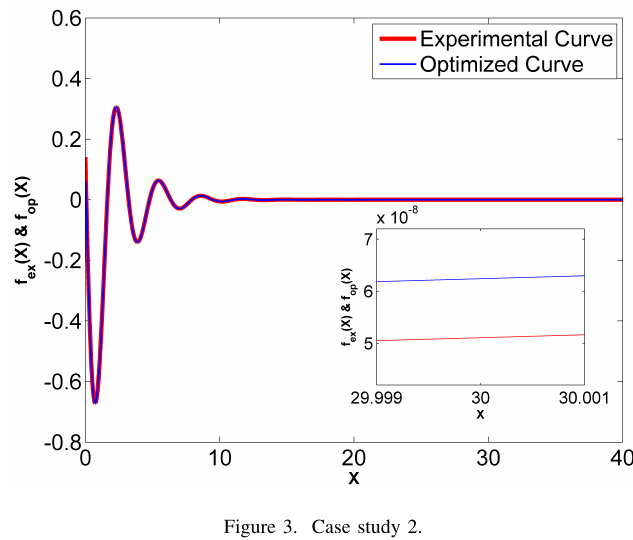
Figure 3. Case study 2.